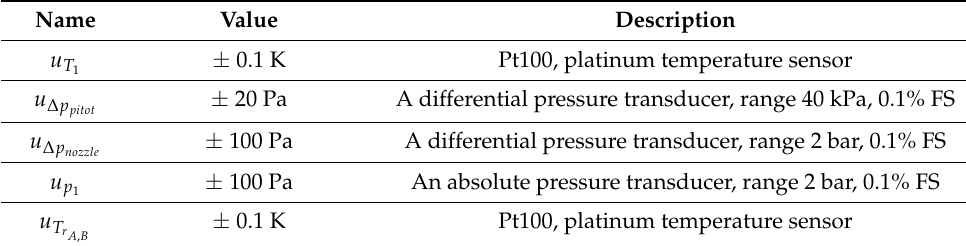
Table 2. Uncertainties of Type B for all measured quantities for velocity